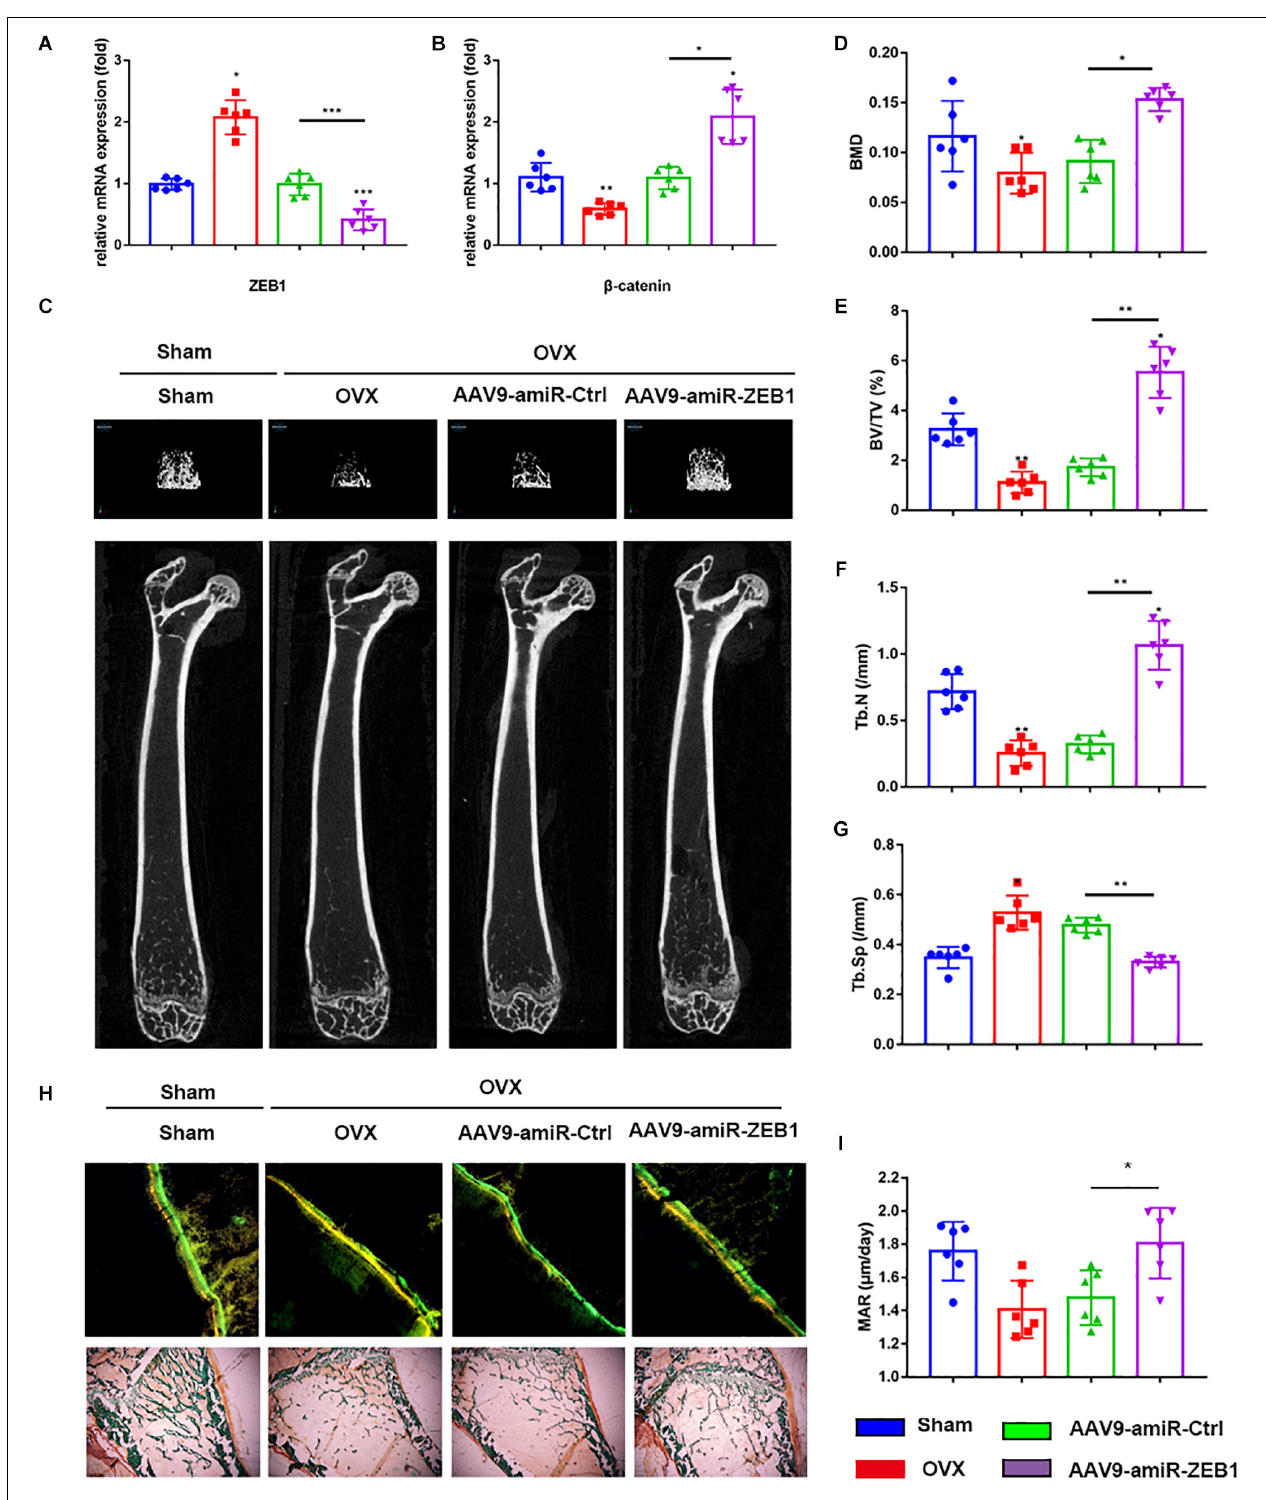
FIGURE 5 | Downregulation of ZEB1 attenuates the bone loss induced by ovariectomy. (A) qRT-PCR analysis revealed that ZEB1 was decreased after injection with AAV9-amiR-ZEB1. (B) qRT-PCR analysis revealed that ZEB1 knockdown promoted the mRNA level of β -catenin in vivo . (C–G) Representative images of microCT. n = 6 biologically independent samples. 3D structural parameters-BMD, BV/TV, Tb.N, and Tb.Sp of femurs measured by microCT in all groups. (H,I) Representative images showing new bone formation were assessed by double fluorescence labeling of calcein and tetracycline and Goldner’s trichrome staining of femurs. 100 × . Histomorphometric analysis of the bone formation-related parameter MAR in all groups. * p -value < 0.05, ** p -value < 0.01 and *** p -value < 0.001.